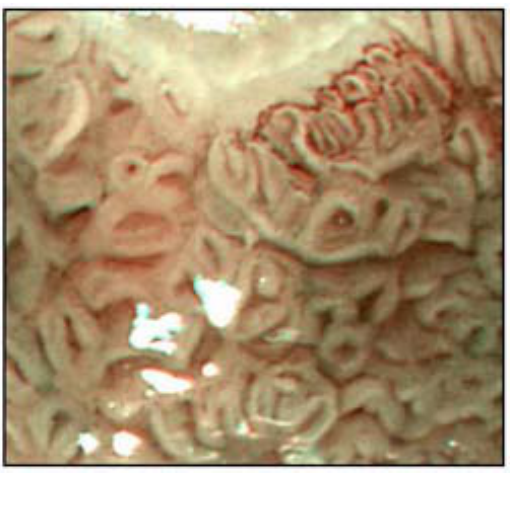
FIGURE 5. Esophago-gastric junction; gastric cardiac epithelium under the Z line: narrow-band imaging coupled to magnification. Epithelial ridges and sulci highly